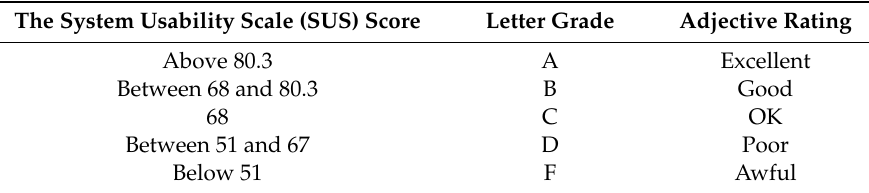
Table 3. The system usability scale (SUS) Grading Scale [39].